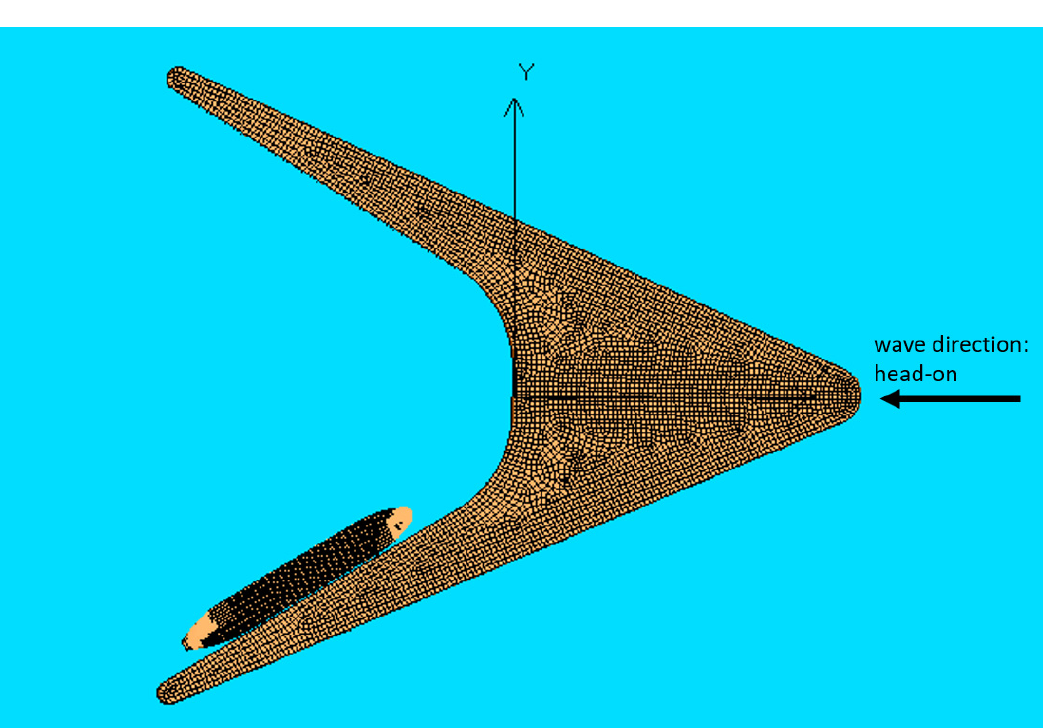
Figure 1. Layout of the moored ship at the sheltered basin of the Delta VLFS.